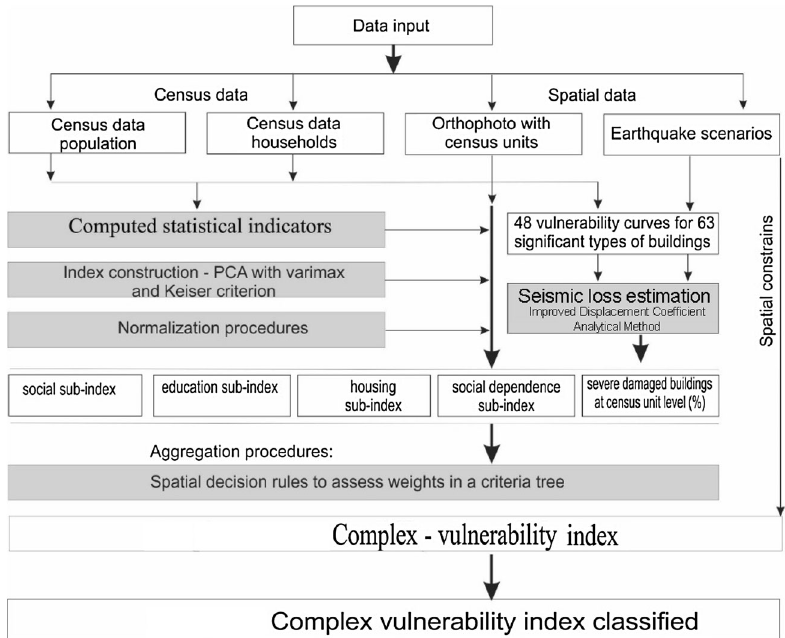
Fig. 3 Methodological flowchart of research design. Darker boxes show the main methods and procedures applied to